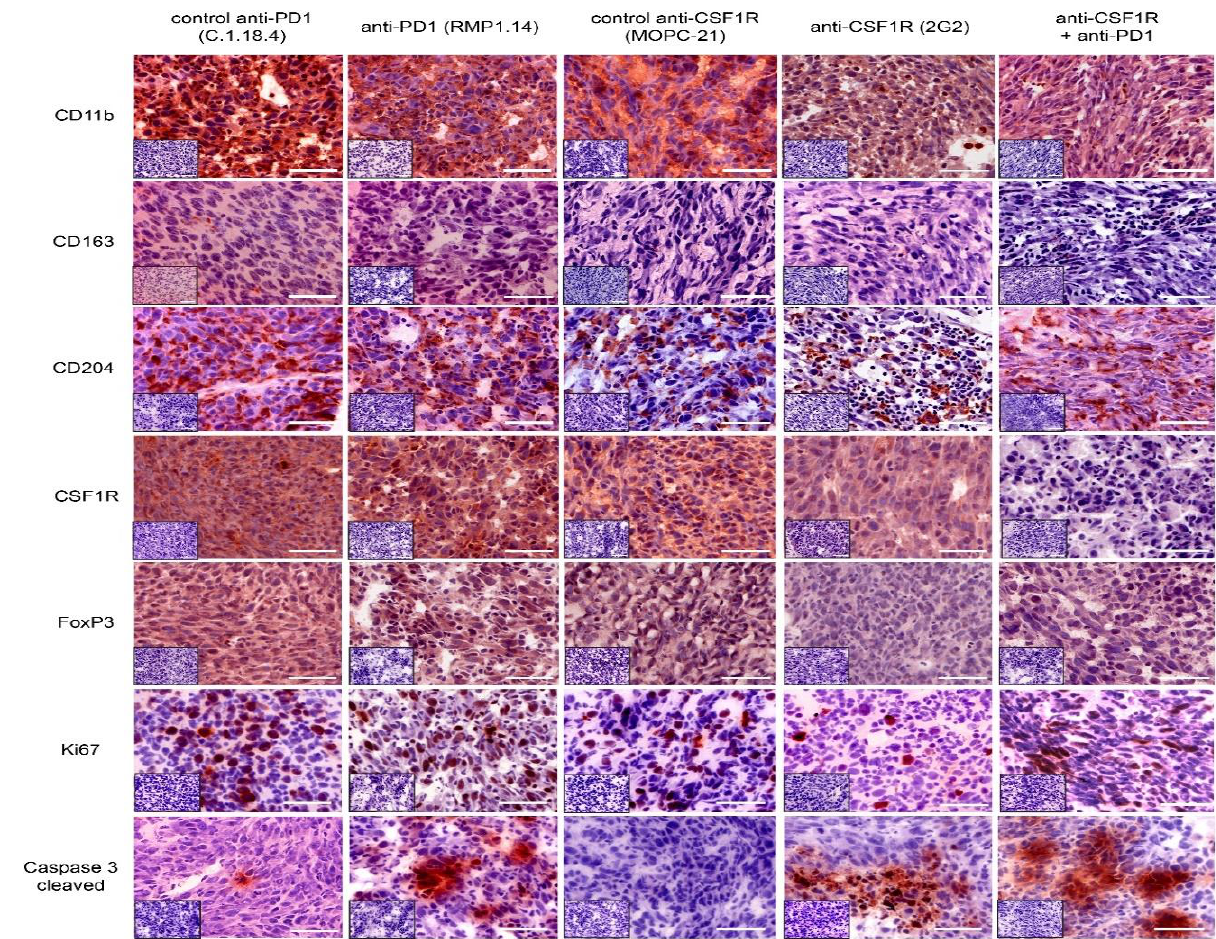
Figure 4. Immunohistochemical analysis in post-treatment tissues ( n = 3 in each group were analysed). Representative IHC staining patterns of tumor tissues with indicated antibodies after 2 injections of CSF1R antibodies and 3 injections of PD1 antibodies. Small inserts show staining control without application of primary antibody. Scale bars 50 µm.